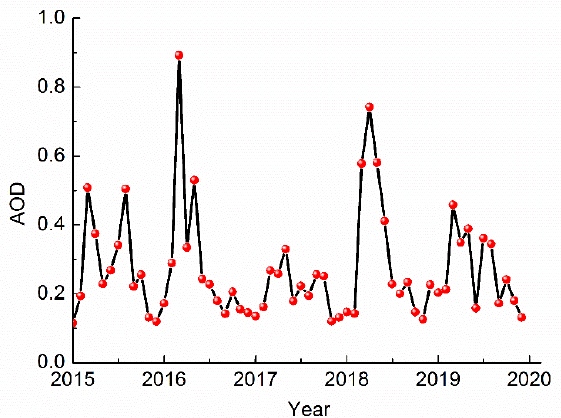
Figure 1. Temporal variation trend in the AOD, averaged over the TB from 2015 to 2019.